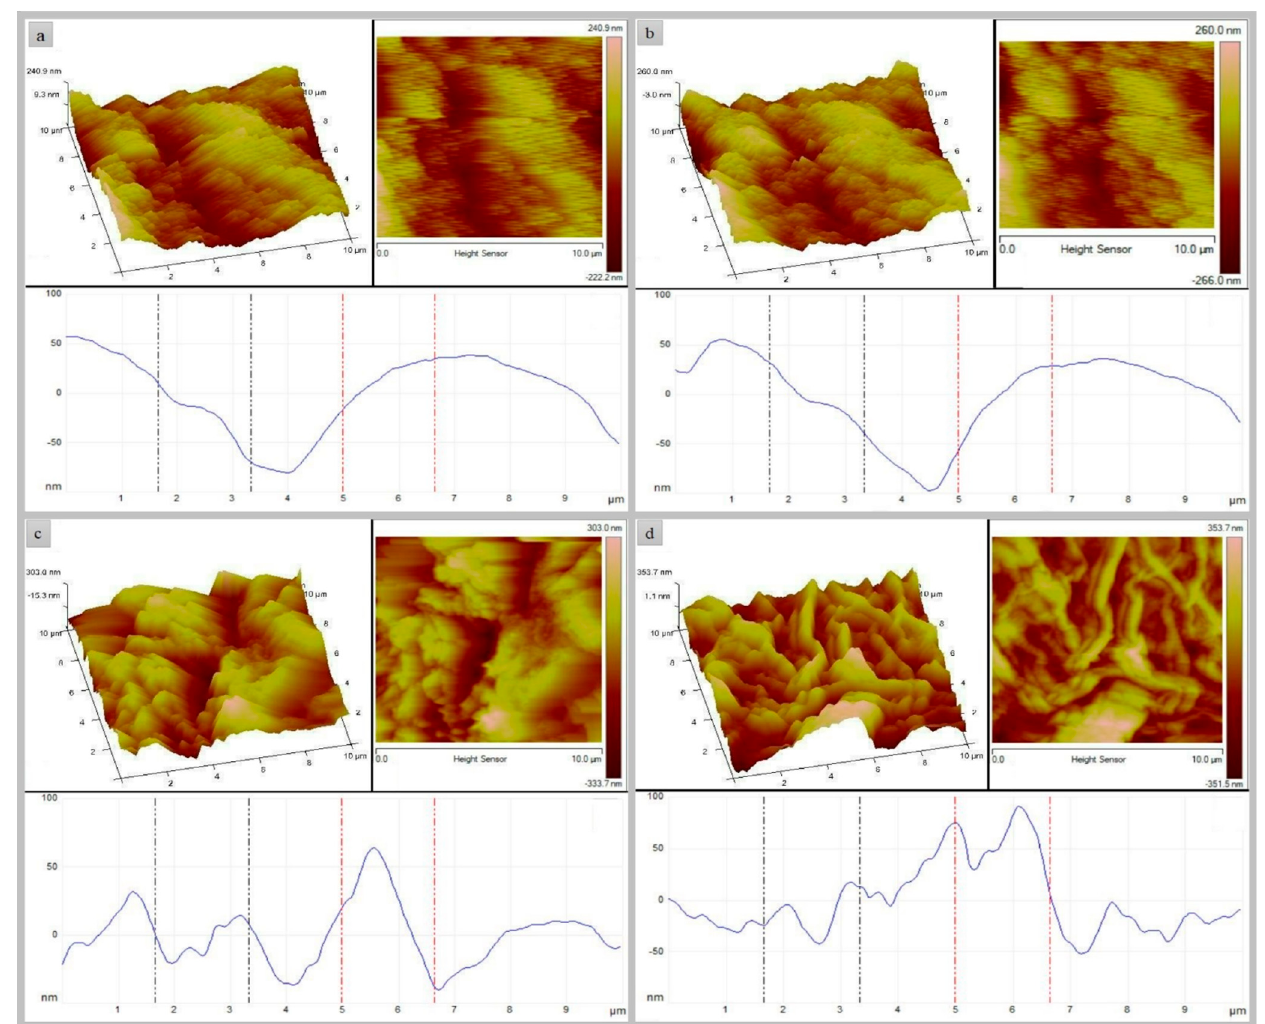
Figure 4. The 3D, 2D, and lateral lines obtained by AFM spectroscopy across an area of 10 × 10 µm 2 for samples: ( a ) S 1 , ( b ) S 2 , ( c ) S 3 , and ( d ) S 4 .